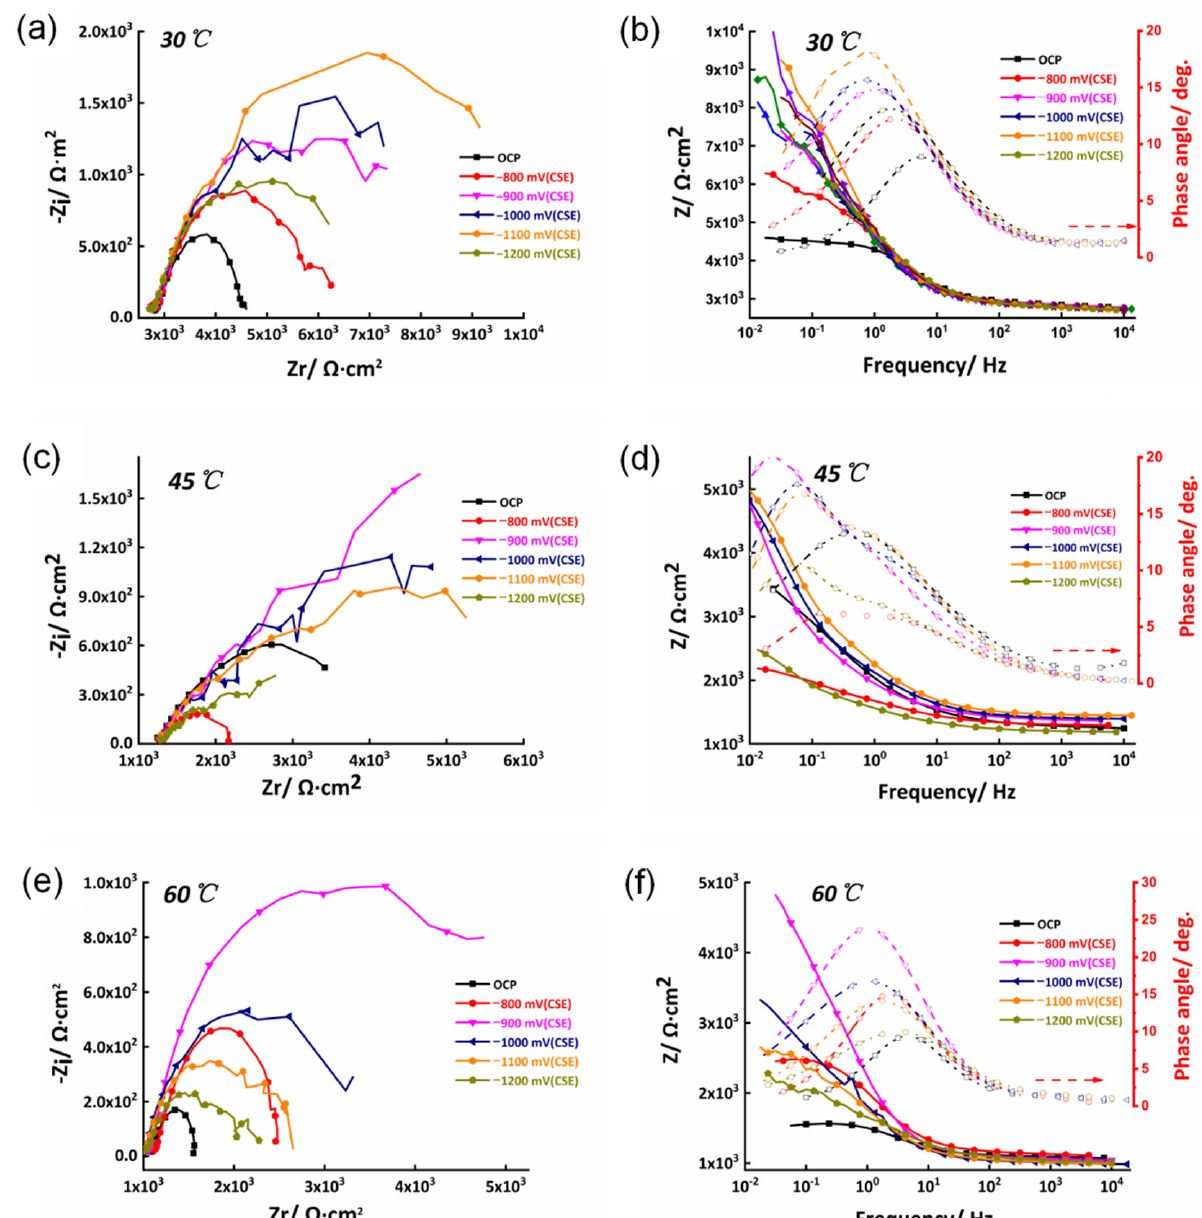
Figure 4. The EIS of the X80 steel under different cathodic polarization potentials and characteristic frequencies at ( a , b ) 30 °C, ( c , d ) 45 °C, and ( e , f ) 60 °C. The EIS data are fitted with the equivalent circuit in Figure 5, where R s is the solution resistance, and Q f and R f are the constant phase angle elements and indicate resistance at the interface between the corrosion product and the X80 matrix. The corrosion product originated from the long-time immersion of the samples into the corrosion medium. Q dl refers to the constant phase angle element of the double layer at the interface between the corrosion product and the corrosion medium. R t represents the charge transfer